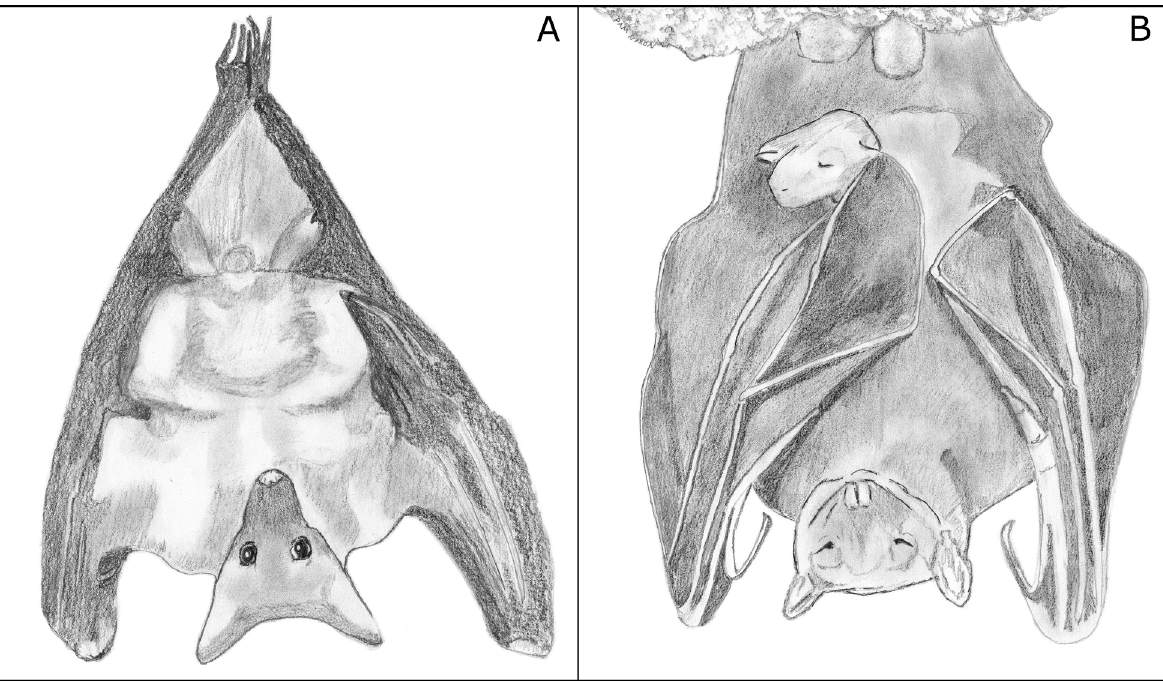
Figure 3. [A] Pregnant female only days before she gives birth. There is a visible bulge in her lower abdominal region, which is formed as the pup becomes properly aligned in the female’s birth canal. [B] Pregnant female Rousettus amplexicaudatus gives birth while hanging upside- down in the pendant position. The pup’s head has already emerged from the female’s vagina. (Illustration courtesy of Pamela